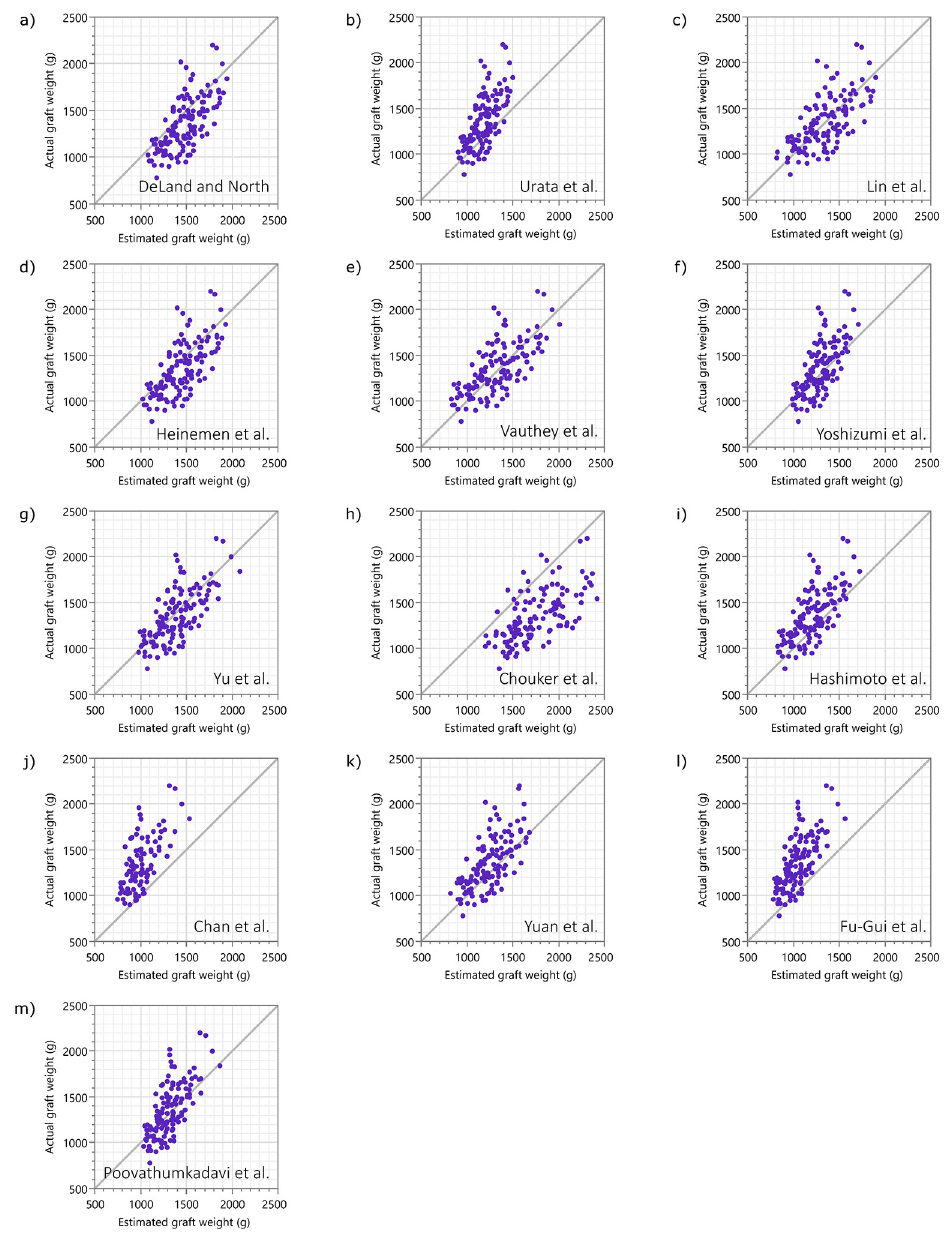
Fig 6. Actual vs. estimated plots of the previously reported models. Scatter plots between the actual graft weight in the current cohort and the estimated graft weight using previously reported formulas. The 45˚ line through the origin represents perfect